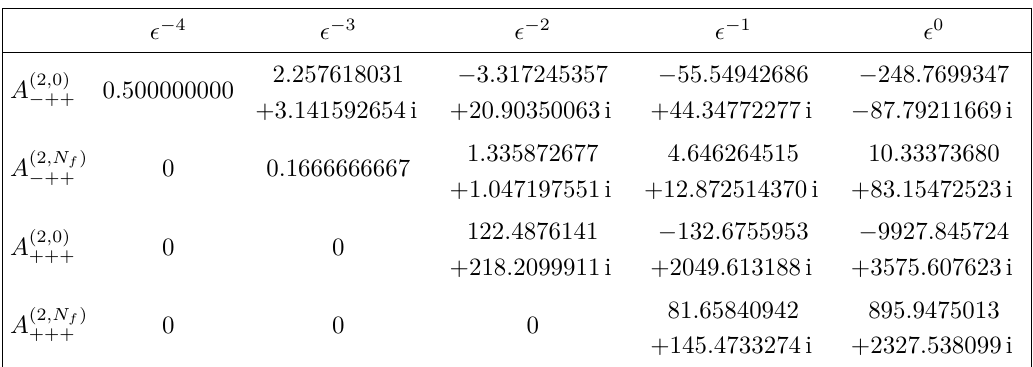
Table 5. Reference evaluations of all independent bare two-loop amplitudes on the phase-space point of eq. (3.12).